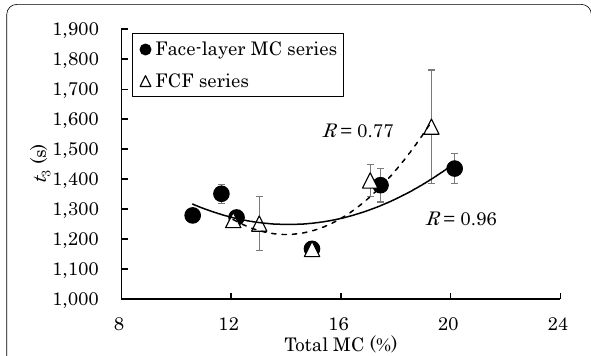
Fig. 10 Relationship between t 3 and total MC for the mats in the face-layer MC and FCF series: the solid and dashed lines are the quadratic regression curves of the face-layer MC and FCF series,